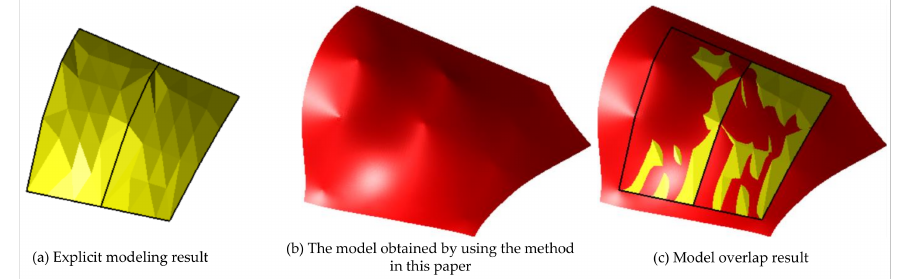
Figure 9. Comparison results of models obtained by different